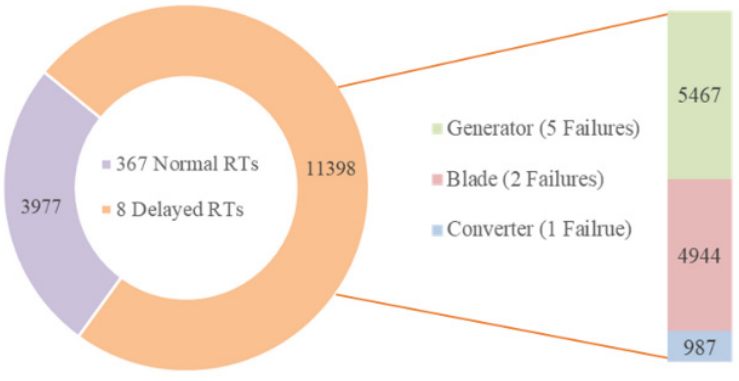
Figure 10. Delayed Figure 10. Delayed RTs/hour.